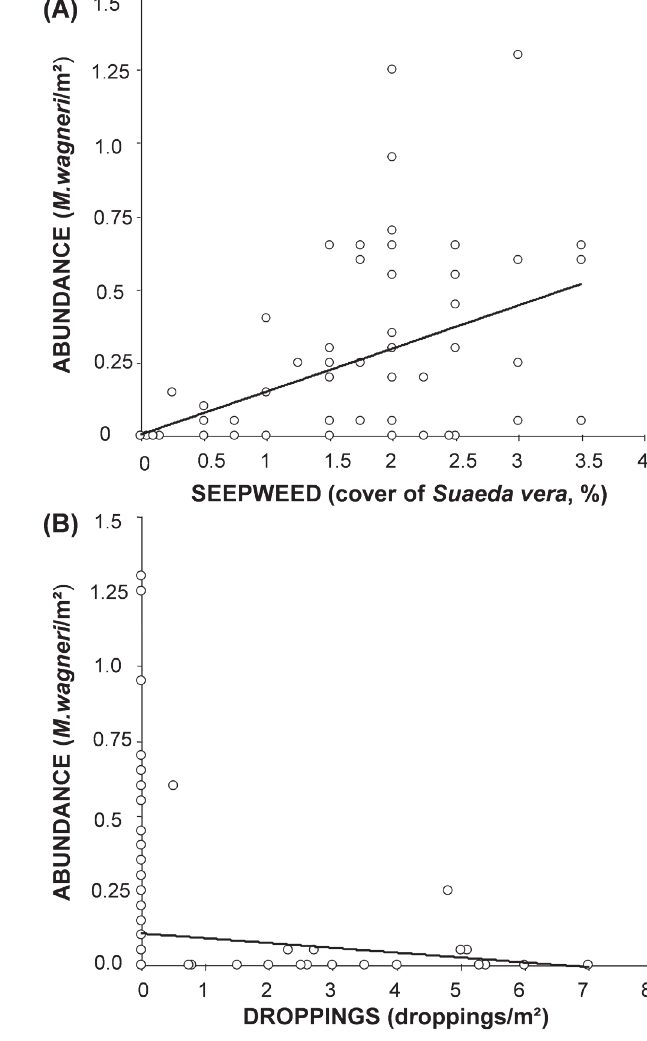
Fig. 4. Relationship between probability of presence of Mioscirtus wagneri in the transects (PRESENCE) and A. Cover (%) of Suaeda vera (SEEPWEED) for extreme values of livestock droppings per square meter (DROPPINGS), and B. Livestock droppings per square meter (DROPPINGS) for extreme values of cover (%) of S. vera (SEEPWEED).